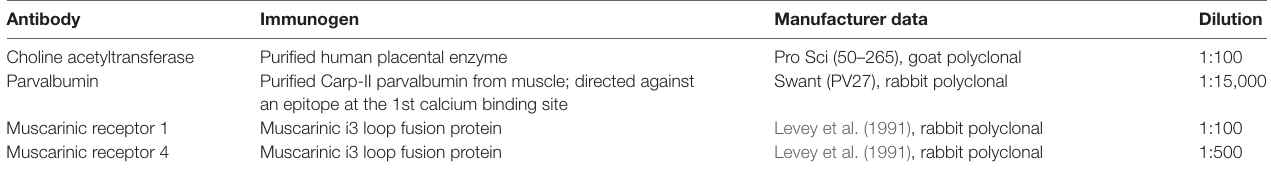
TABLE 1 | Sources of primary antibodies used in the study.